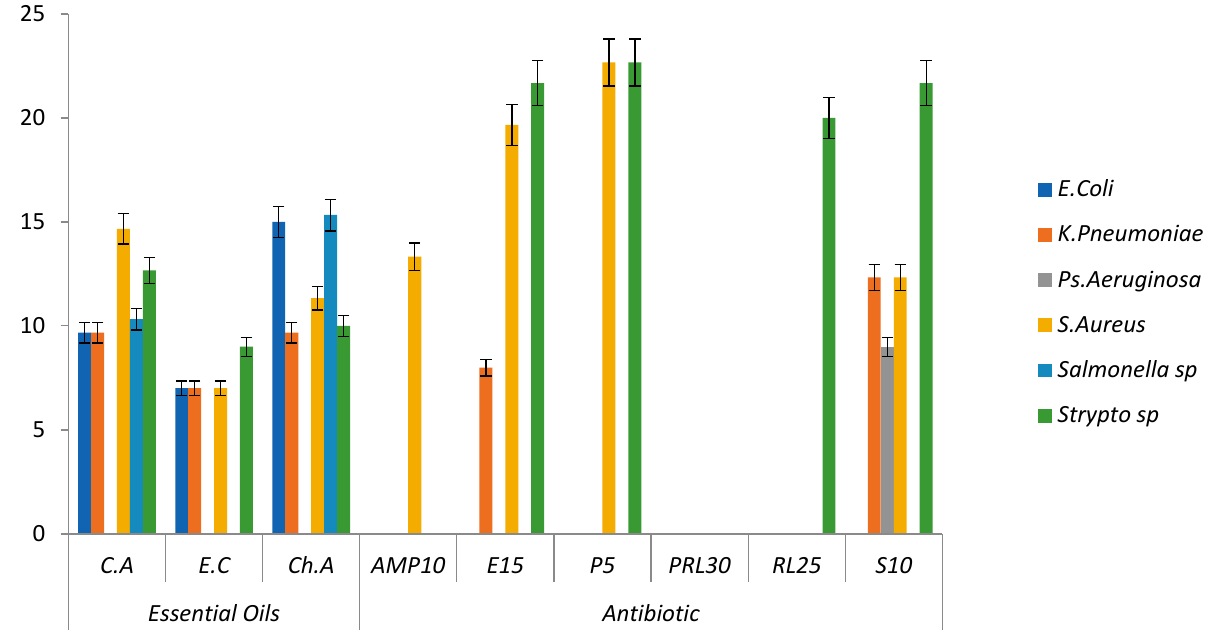
Figure 1. The effects of substances (essential oil and antibiotics) on the diameter of the inhibition zone. Data are presented as means (±SE).